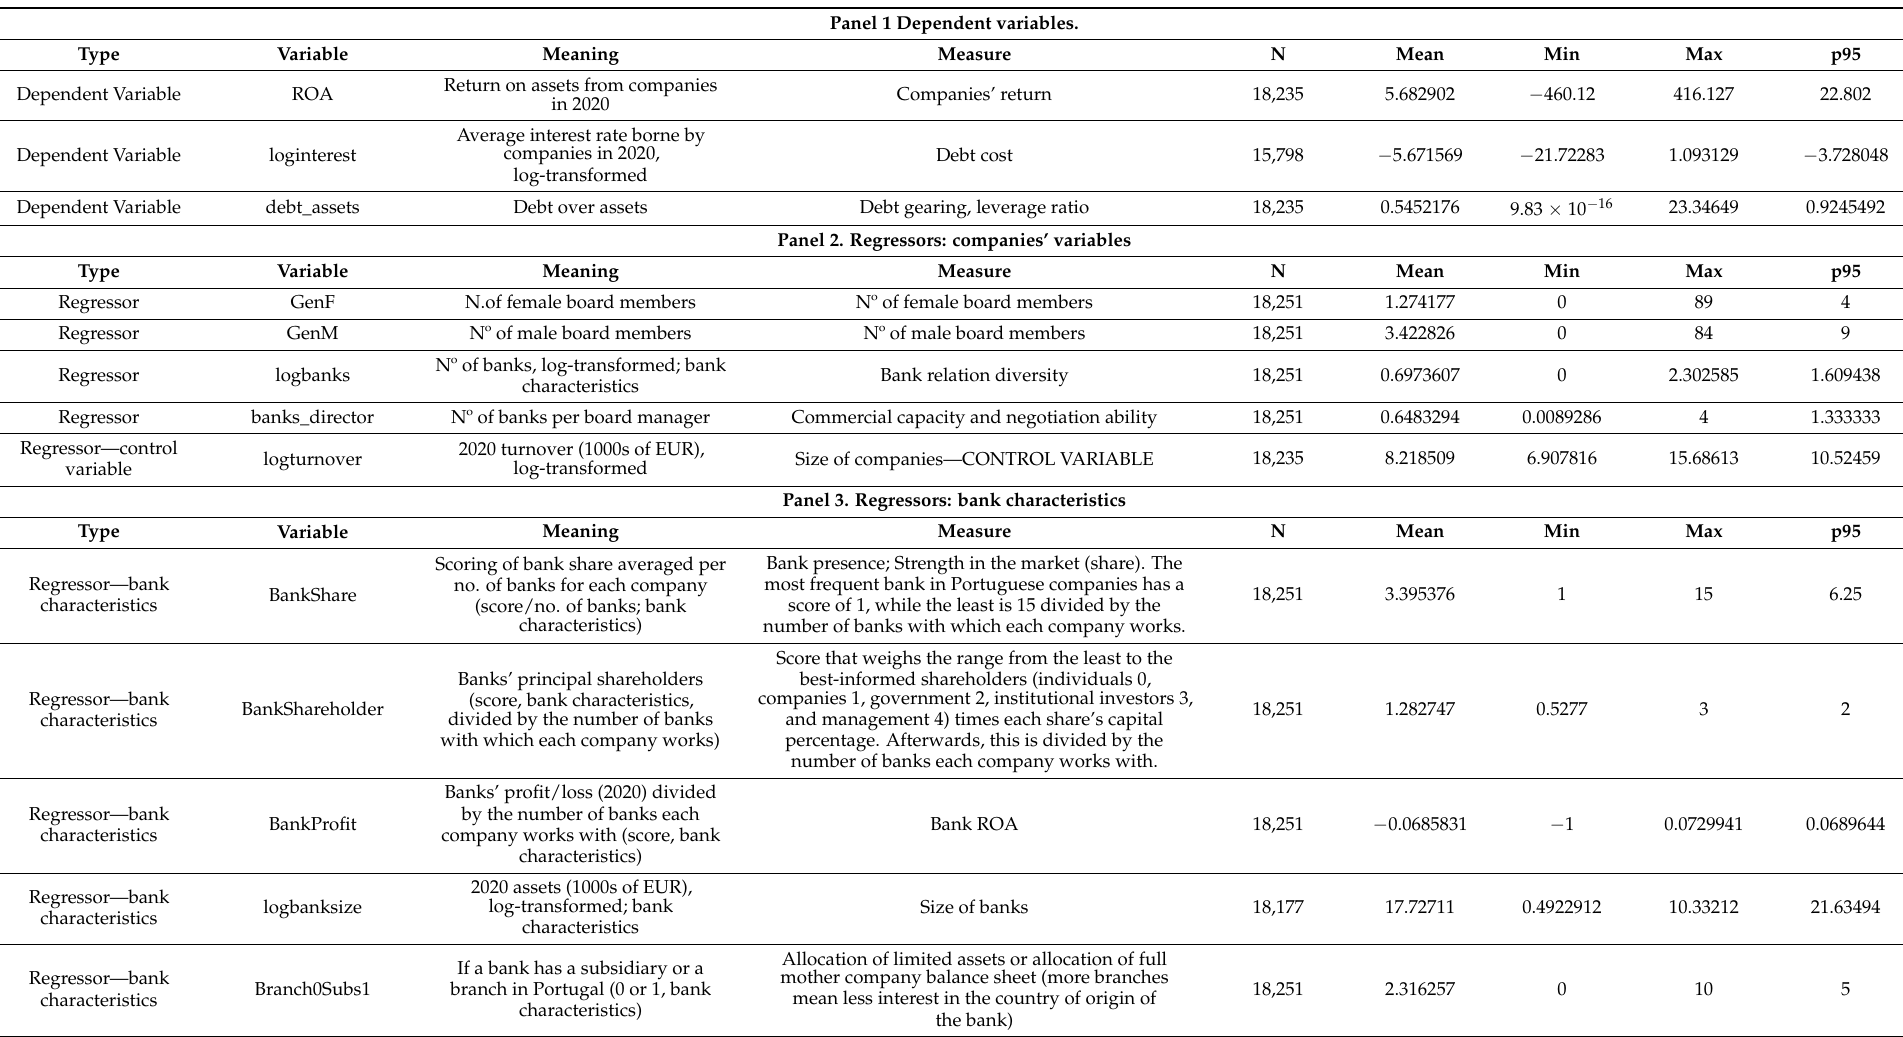
Table 3. Descriptive statistics, variables, and measures.